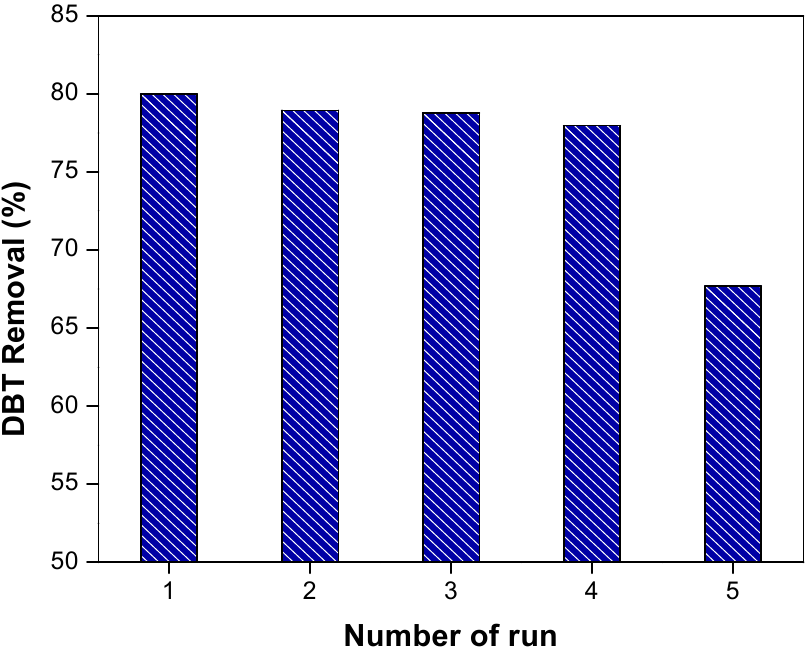
Figure 7. The effect of catalyst recycling (1–5 runs) on DBT conversion. Conditions: 15 mL of 1200 ppm DBT solution, 2 mL H 2 O 2 /HCOOH, 0.08 g catalyst, and 15 min reaction time at 40 °C.